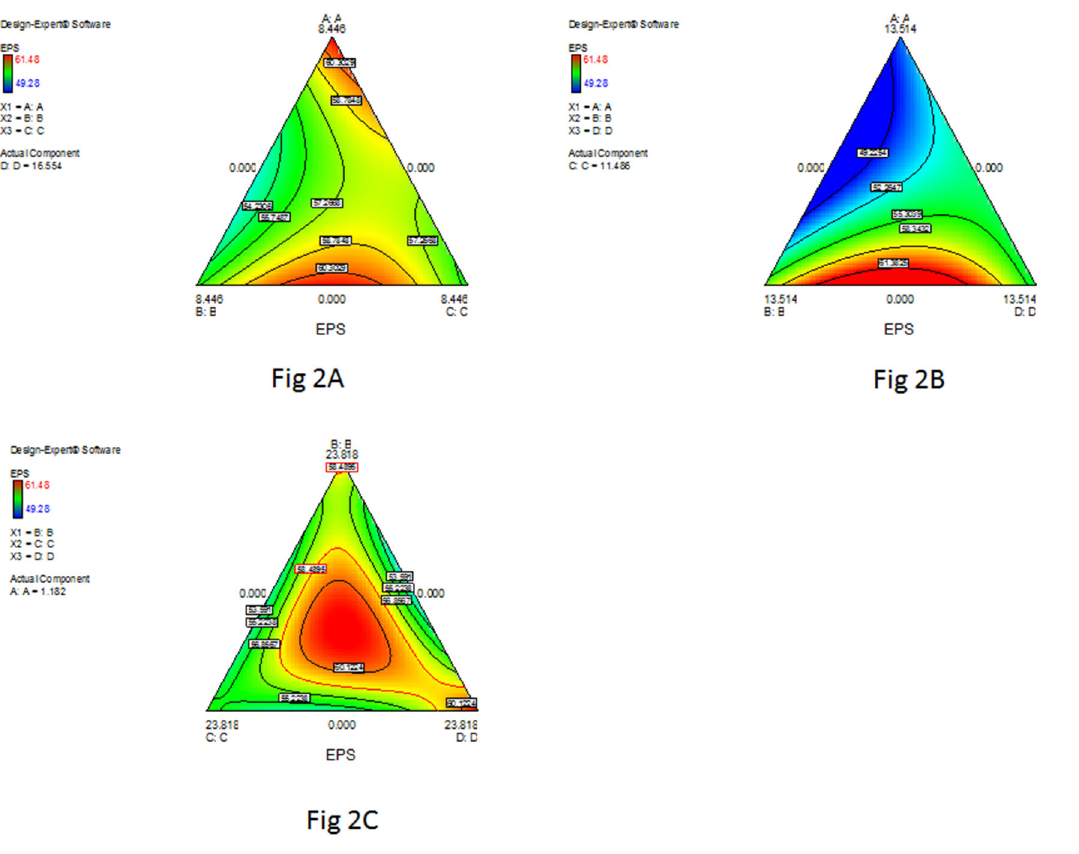
Figure 2. Interaction among Ethanol (A), Acetone (B) and IPA(C) at constant concentration of THF (D). B Interaction among Ethanol (A), Acetone (B) and THF (D) at a fixed concentration of IPA(C). C Interaction among Acetone (B), IPA (C) and THF (D) at a definitive concentration of Ethanol